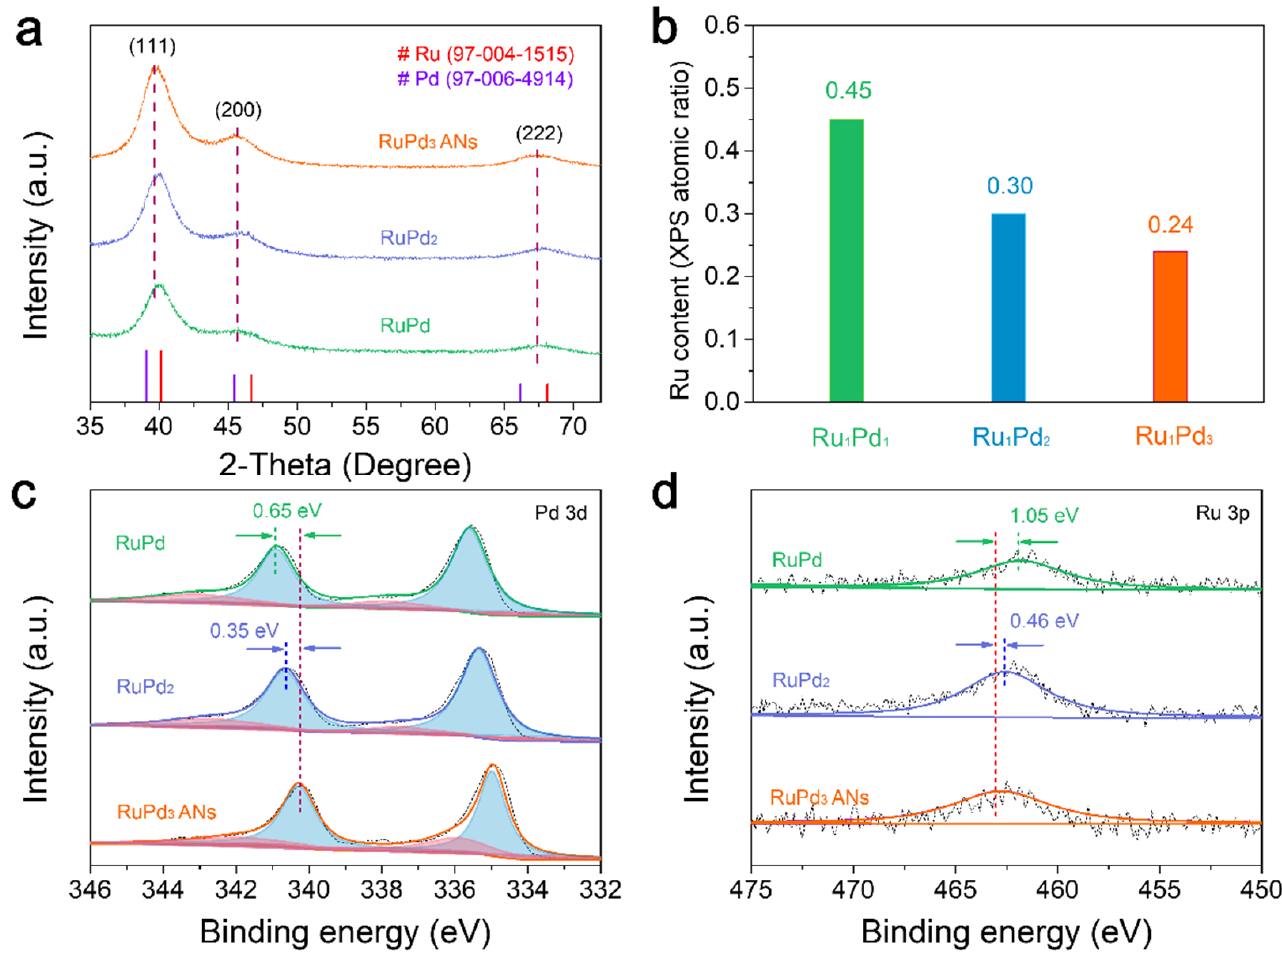
Figure 2. ( a ) XRD pattern; ( b ) X ‐ ray photoelectron spectroscopy (XPS) spectrum of surface element ratio; ( c ) XPS spectrum of Pd 3 d ; and ( d ) Ru 3 p for RuPd 3 ANs (Orange), RuPd 2 (Blue) and RuPd (Green).